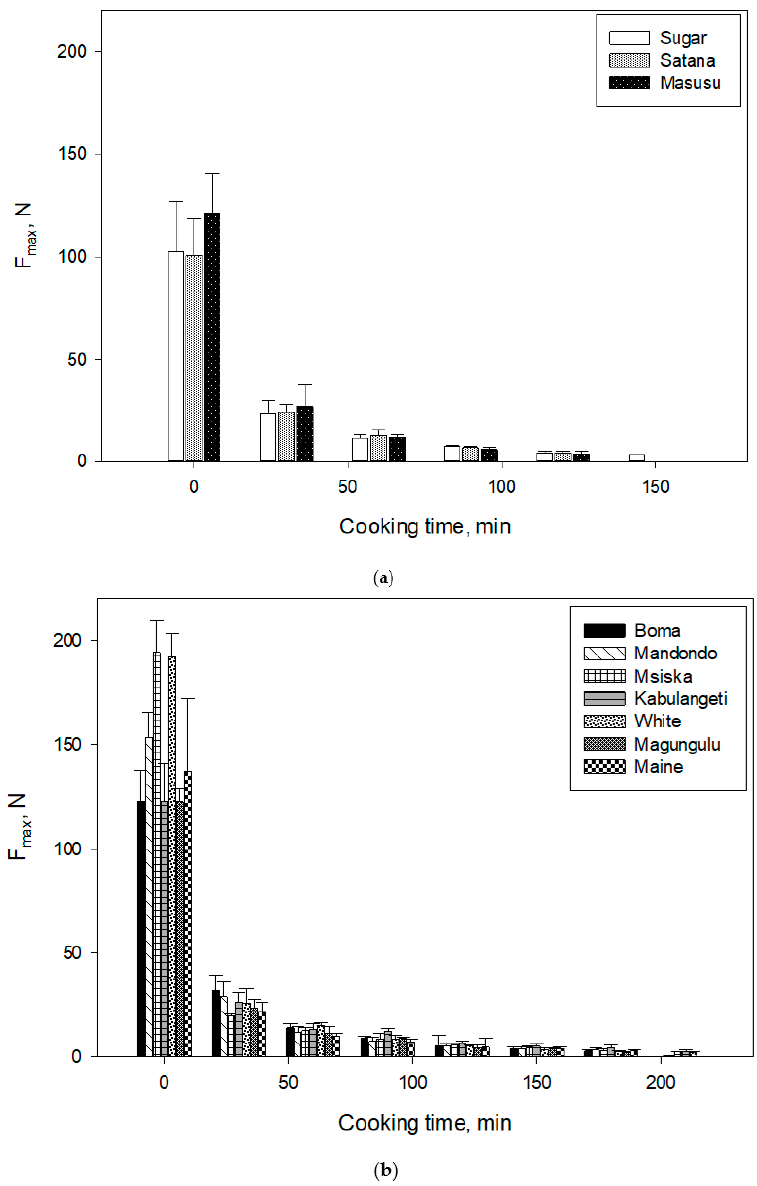
Figure 2. Objective hardness test of the bean cultivars ( a ) ETC cultivars ( b ) HTC